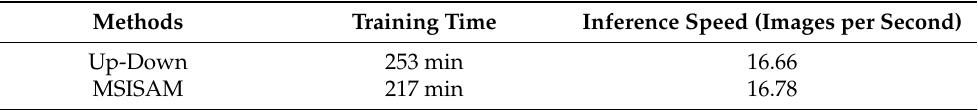
Table 10. Comparison between MSISAM and Up-Down, in terms of training time and inference speed (images per